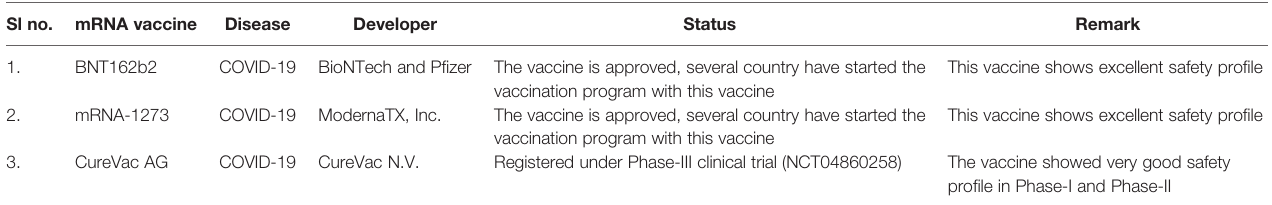
TABLE 4 | mRNA vaccines (approved/last part of Phase-III trial) which showing very good safety pro fi le.